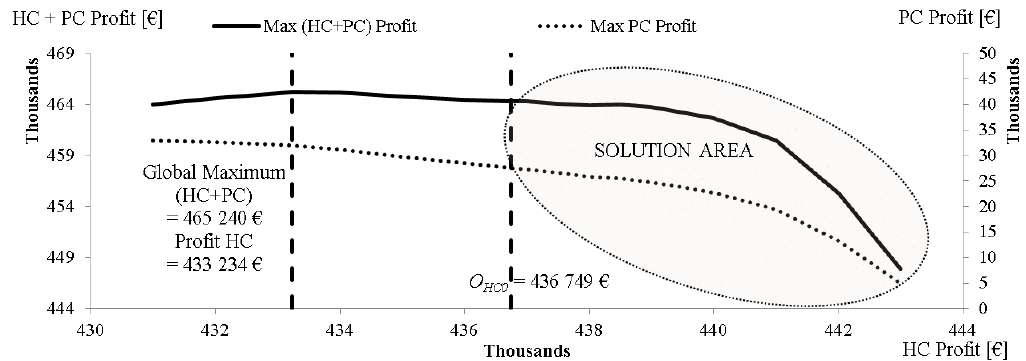
Figure 5. Set of possible solutions.